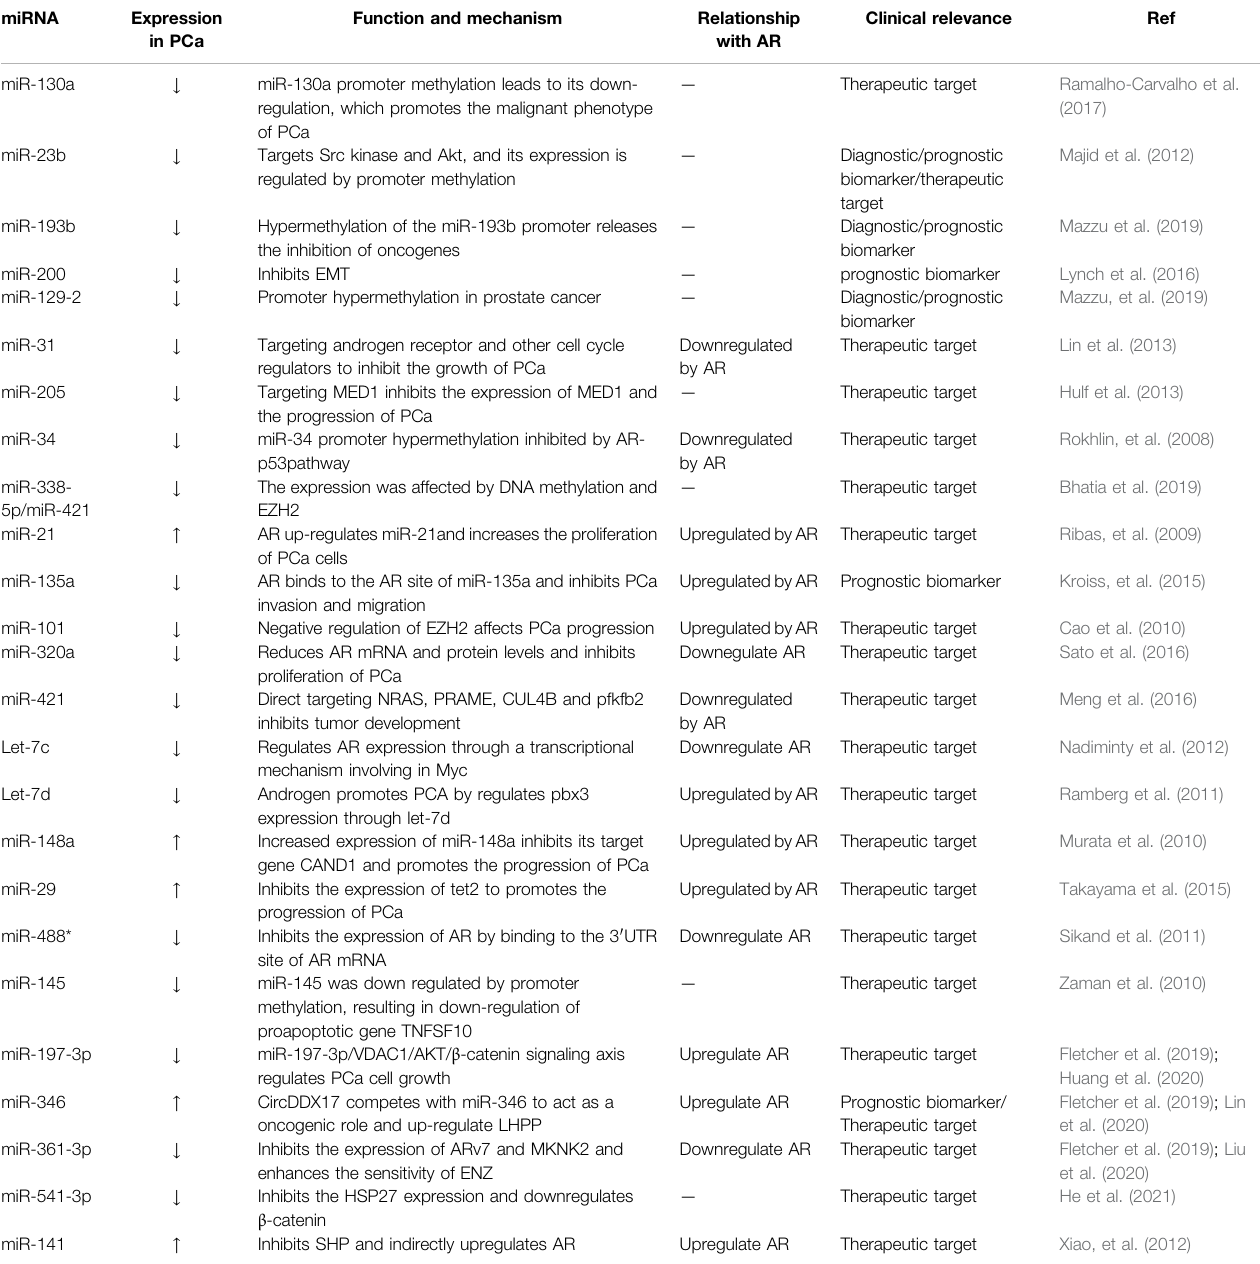
TABLE 3 | miRNAs as epigenetic